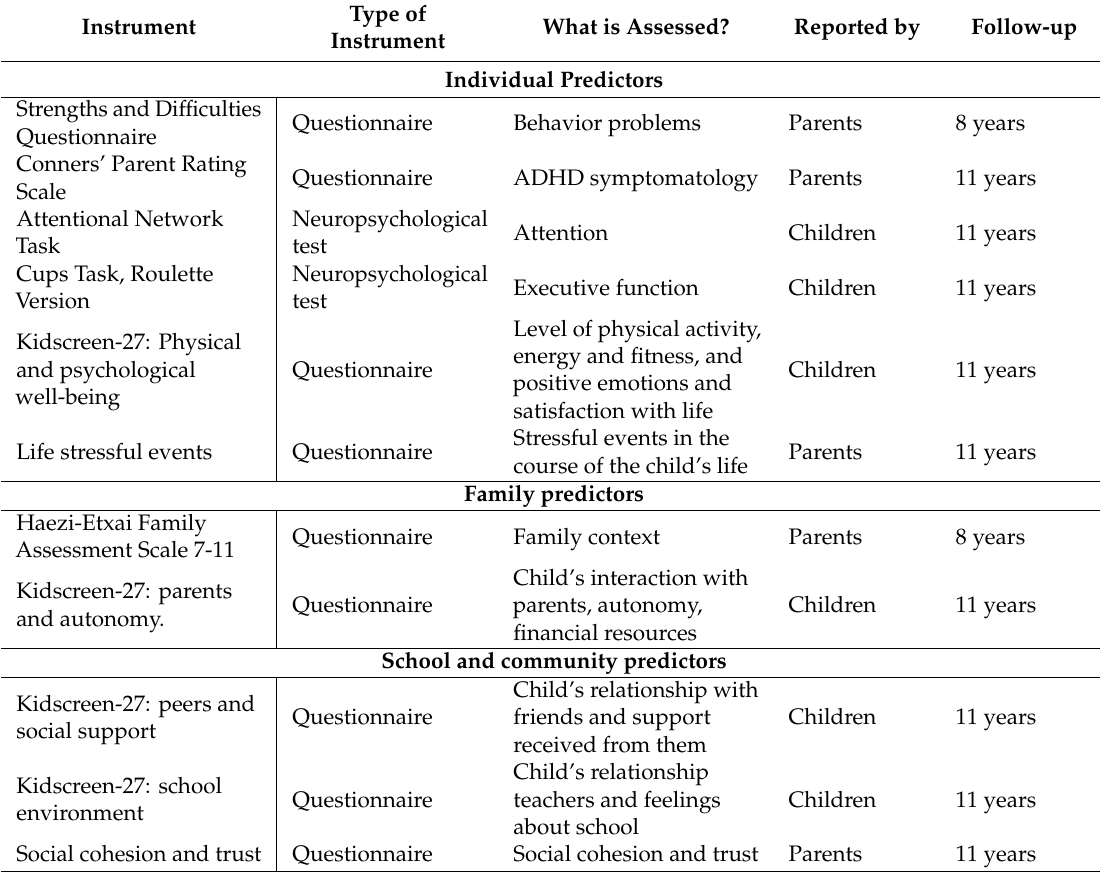
Table 1. Summary of instruments